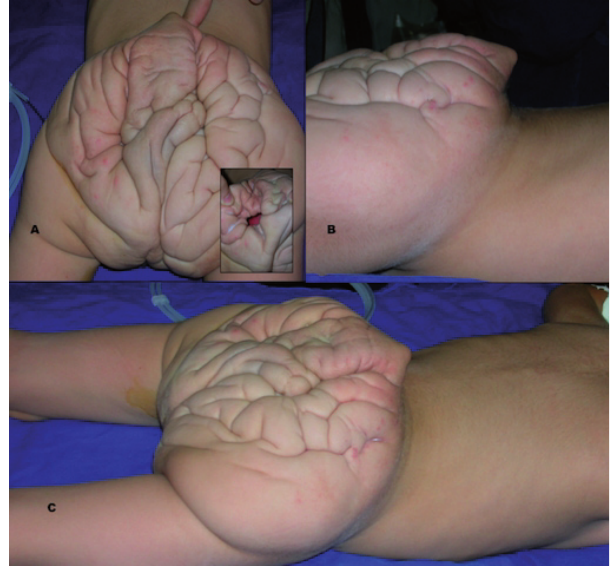
lumbar dysrrhaphism and pubic dyastasis. The dorsal bony promi- nence corresponded to the sacrococcygeal spine, whose abnormal concavity oriented its tip upward, like a small tail. The contrast injection through the orifice of the mass showed a large cavity that extended sagittally and laterally. MRI confirmed the